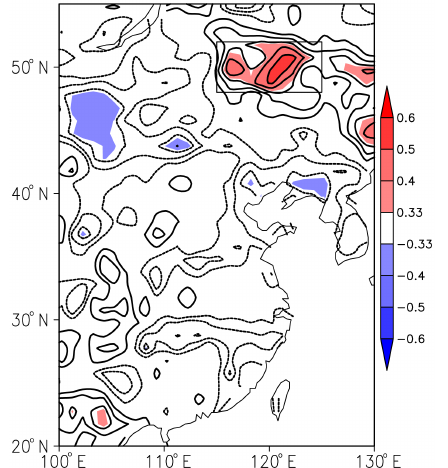
Figure 12. The CC between WHD NCP DY and soil moisture DY in summer from 1980 to 2013. The shades indicate that the CC ex- ceeded the 95% confidence level, and the rectangle represents the selected region (48–52 ◦ N, 115–125 ◦ E) of predictor x 6 .